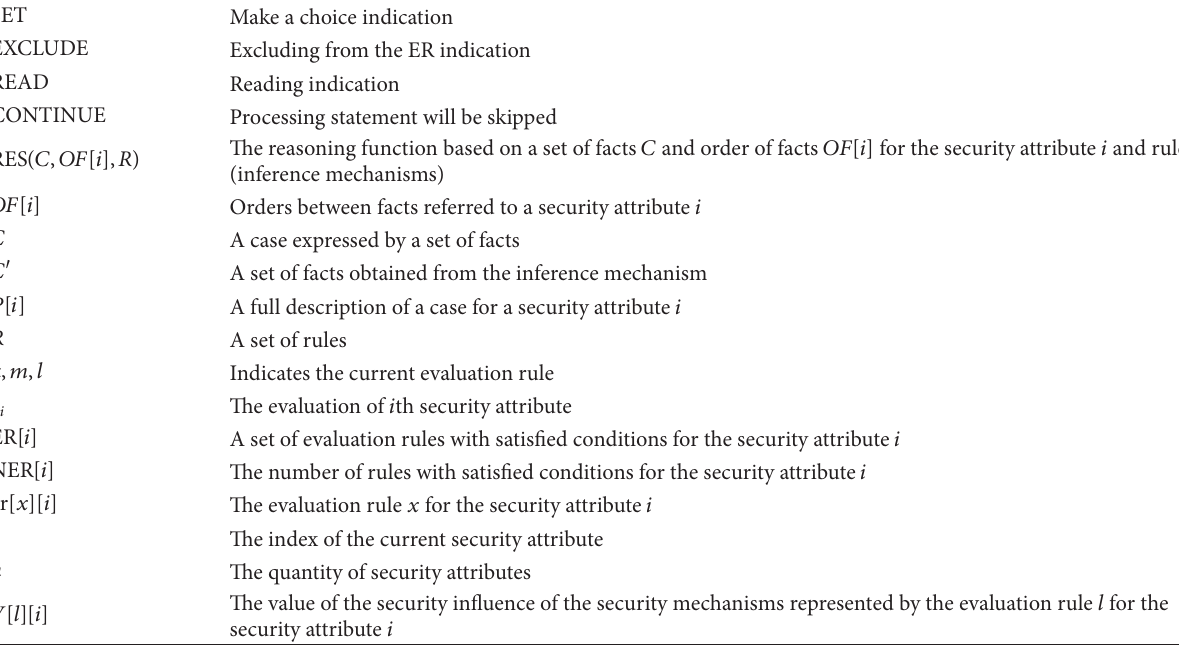
Table 3: The parameters and variables for the security attributes evaluation